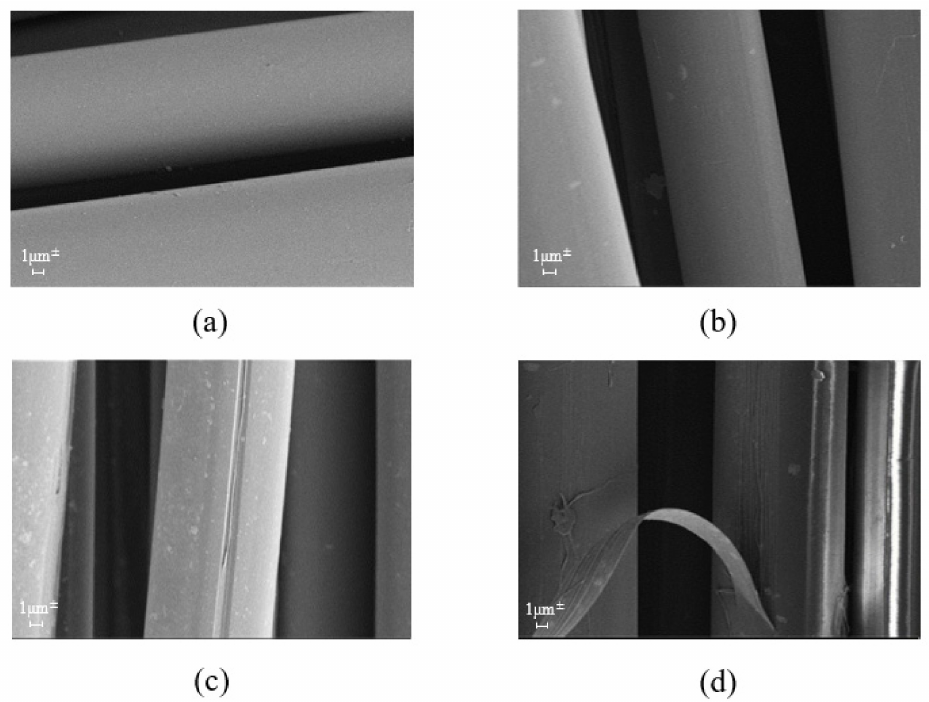
Figure 10. SEM images of the surface treatment with the ZnCl 2 treatment time. ( a ) Untreated, ( b ) 2 h,